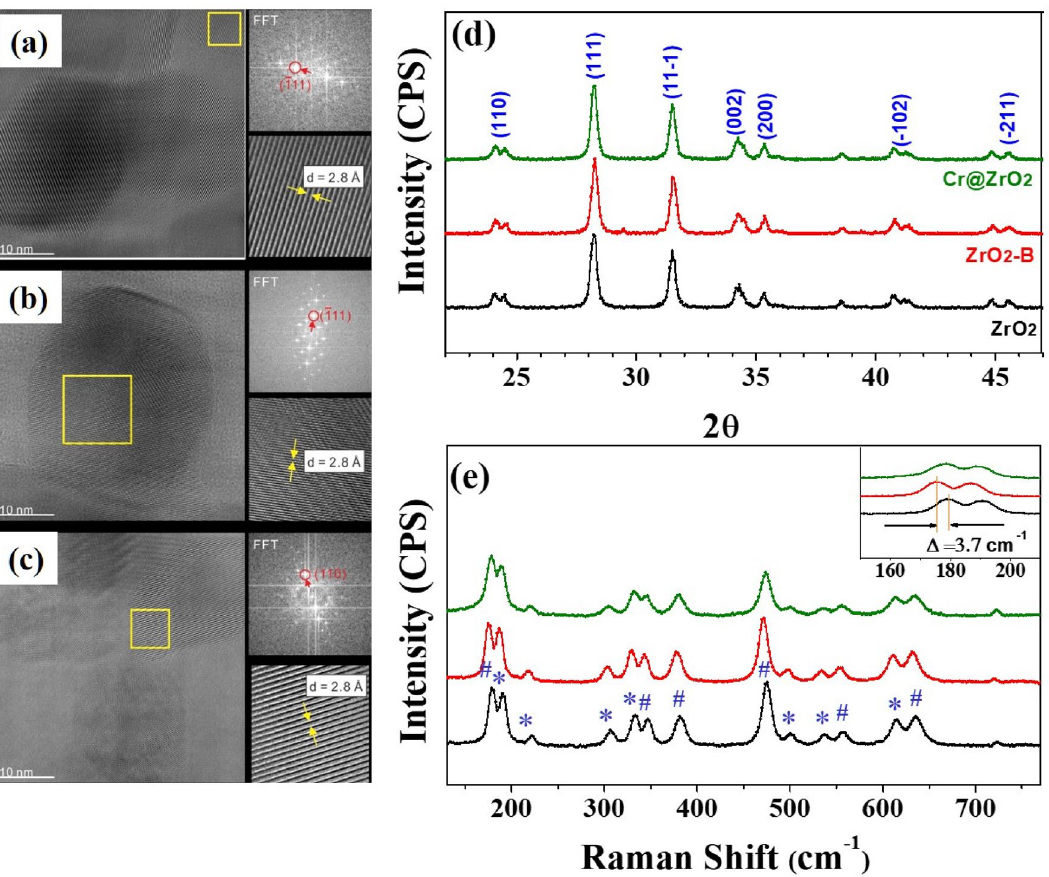
Figure 1. High-resolution TEM images and electron diffraction patterns of ( a ) ZrO 2 ( b ) ZrO 2 -B, and ( c ) Cr@ ZrO 2 NPs. ( d ) XRD patterns and ( e ) Raman spectra of ZrO 2 , ZrO 2 -B, and Cr@ZrO 2 NPs. The inset of ( e ) shows the Raman shift of ZrO 2 -B NPs toward the lower energy region. # and * indicate the A g and B g Raman vibrational modes,